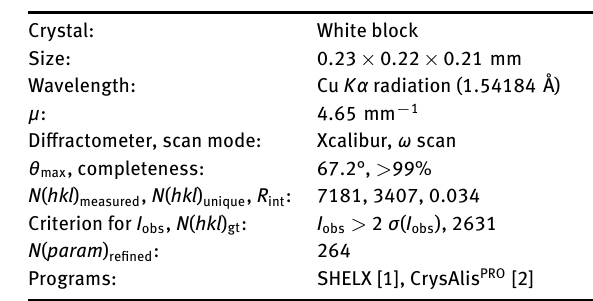
Table 1: Data collection and